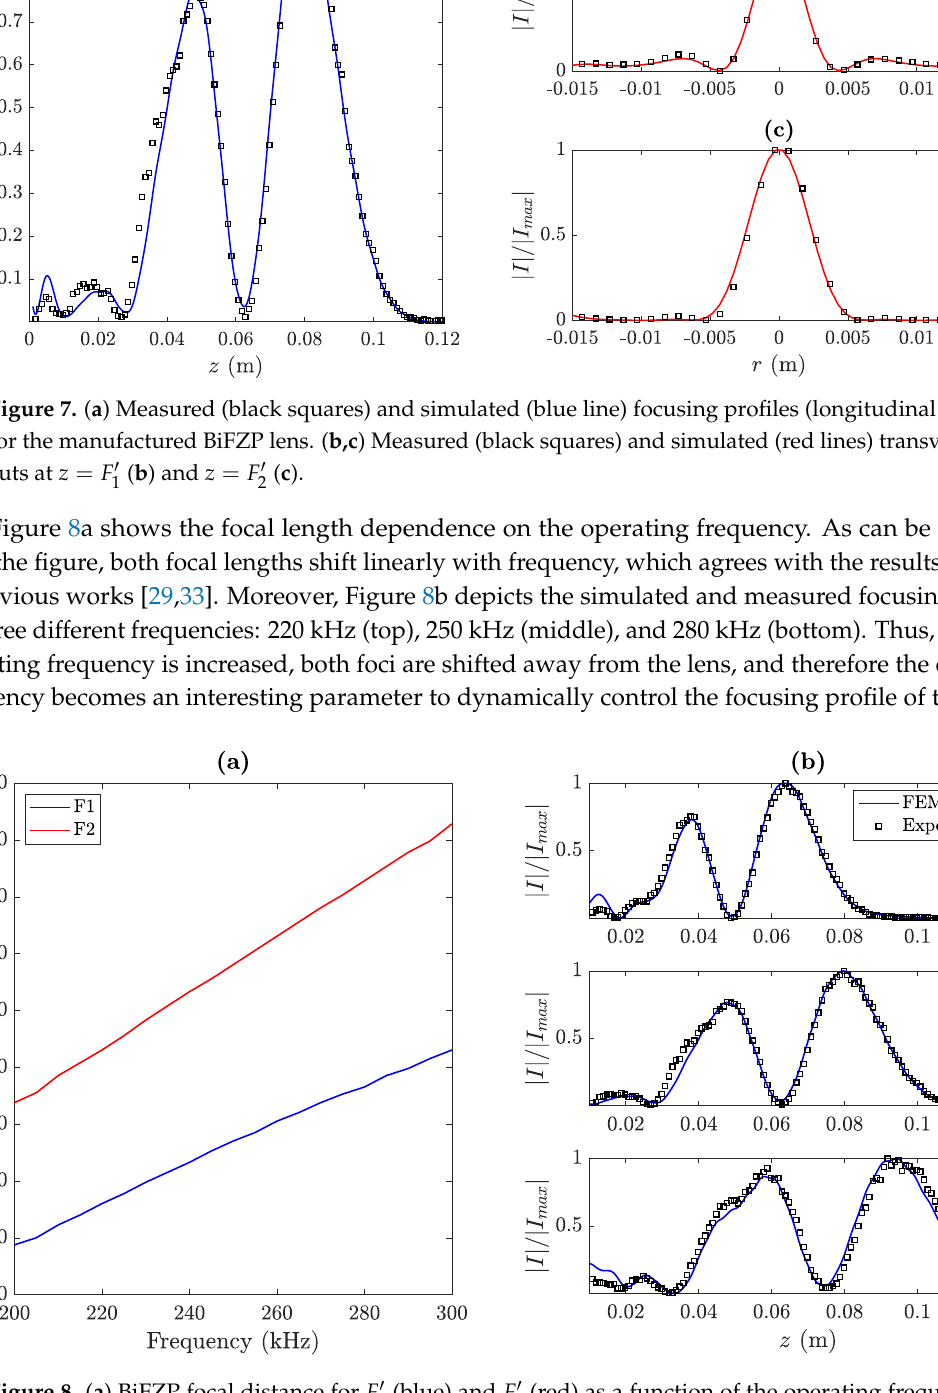
(blue) and F (cid:48) (red) as a function of the operating frequency 2 1